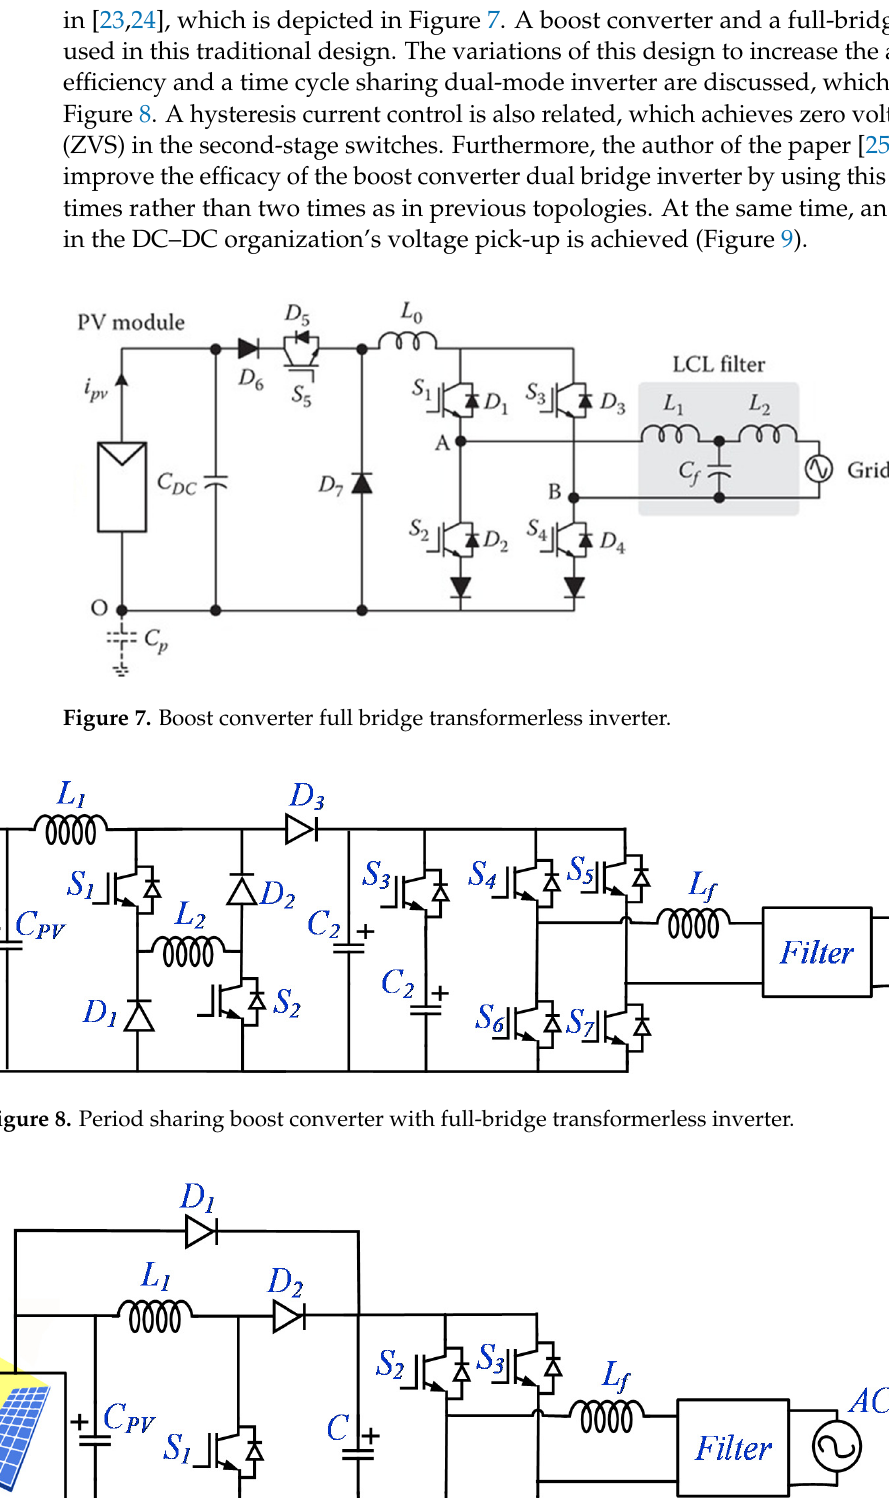
Figure 6. Block diagram of two-stage topology transformerless inverter .